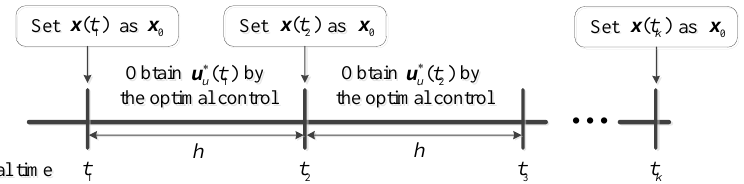
Figure 6. Algorithm schematic diagram of the MPC